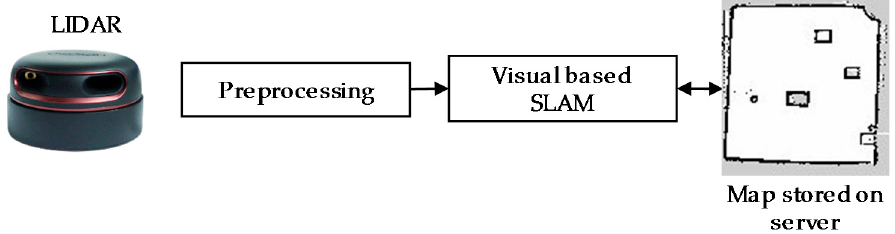
Figure 5. Mapping processes.